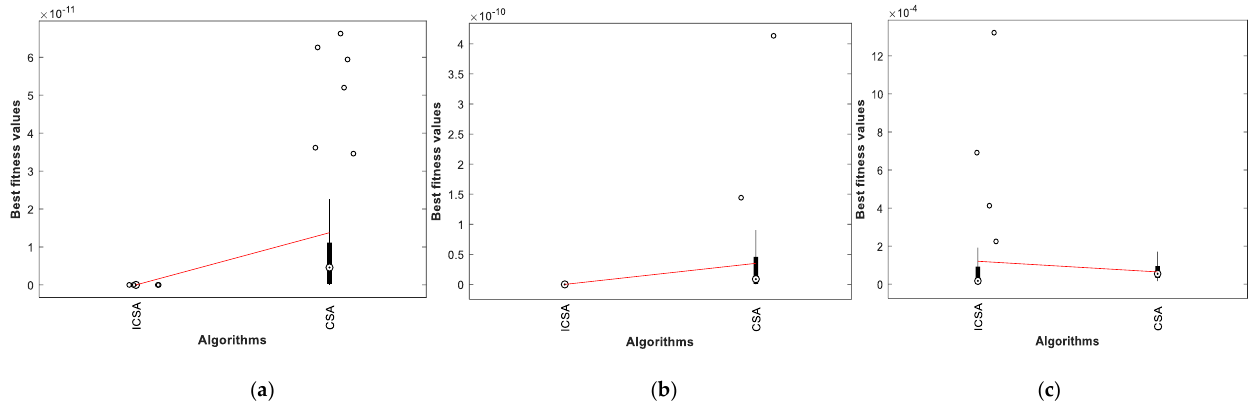
Figure 28. Boxplot of CSA and ICSA for various test cases : ( a ) Boxplot for F7; ( b ) Boxplot for F8; ( c ) Boxplot for F9.